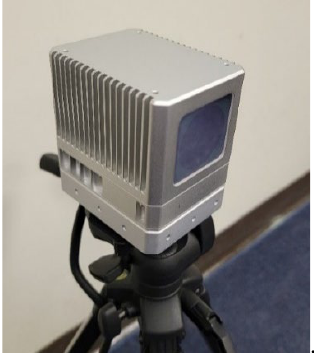
Figure 2. Livox ® Mid–40 as mounted on a camera tripod.